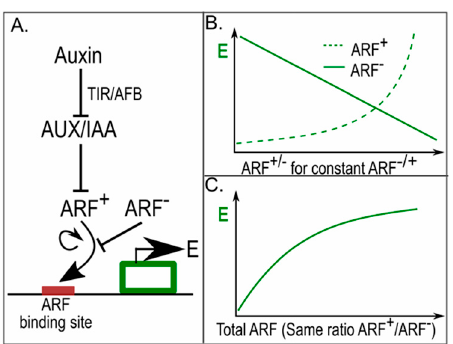
Figure 4. In phyllotaxis, different amounts of ARFs result in differential auxin sensitivity [51]. ( A ) Auxin response network, with auxin de-repressing the AUX/IAA repressed activating ARFs (ARF + ), activating and repressive ARFs (ARF − ) competing for the same auxin response elements (ARE) upstream of auxin responsive genes, and gene expression levels (E) cooperatively depending on activating ARFs; Lines ending with arrowheads indicate positive regulatory interactions, lines ending with a horizontal line indicate negative regulatory interactions; ( B ) Gene expression in response to different levels of repressive and activating ARFs, for constant amounts of activating and repressive ARFs respectively. The non-linear response to activating ARFs arises from their cooperative effects on gene expression; ( C ) Gene expression levels in response to different amounts of activating and repressive ARFs for a constant ratio between the activating and repressive ARFs.